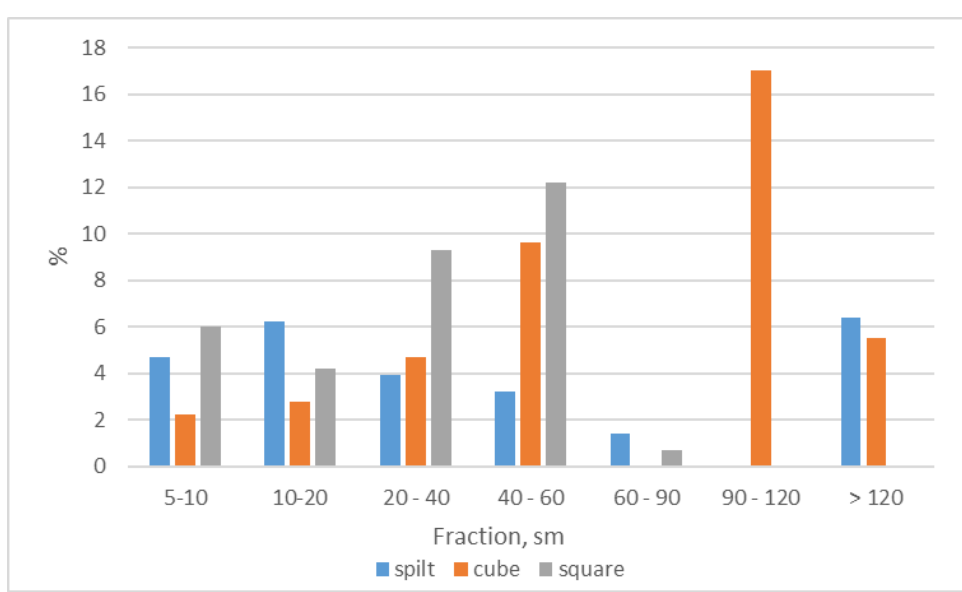
Figure 13. Fragment form distribution by fractions for the 1st stage of the first experiment.